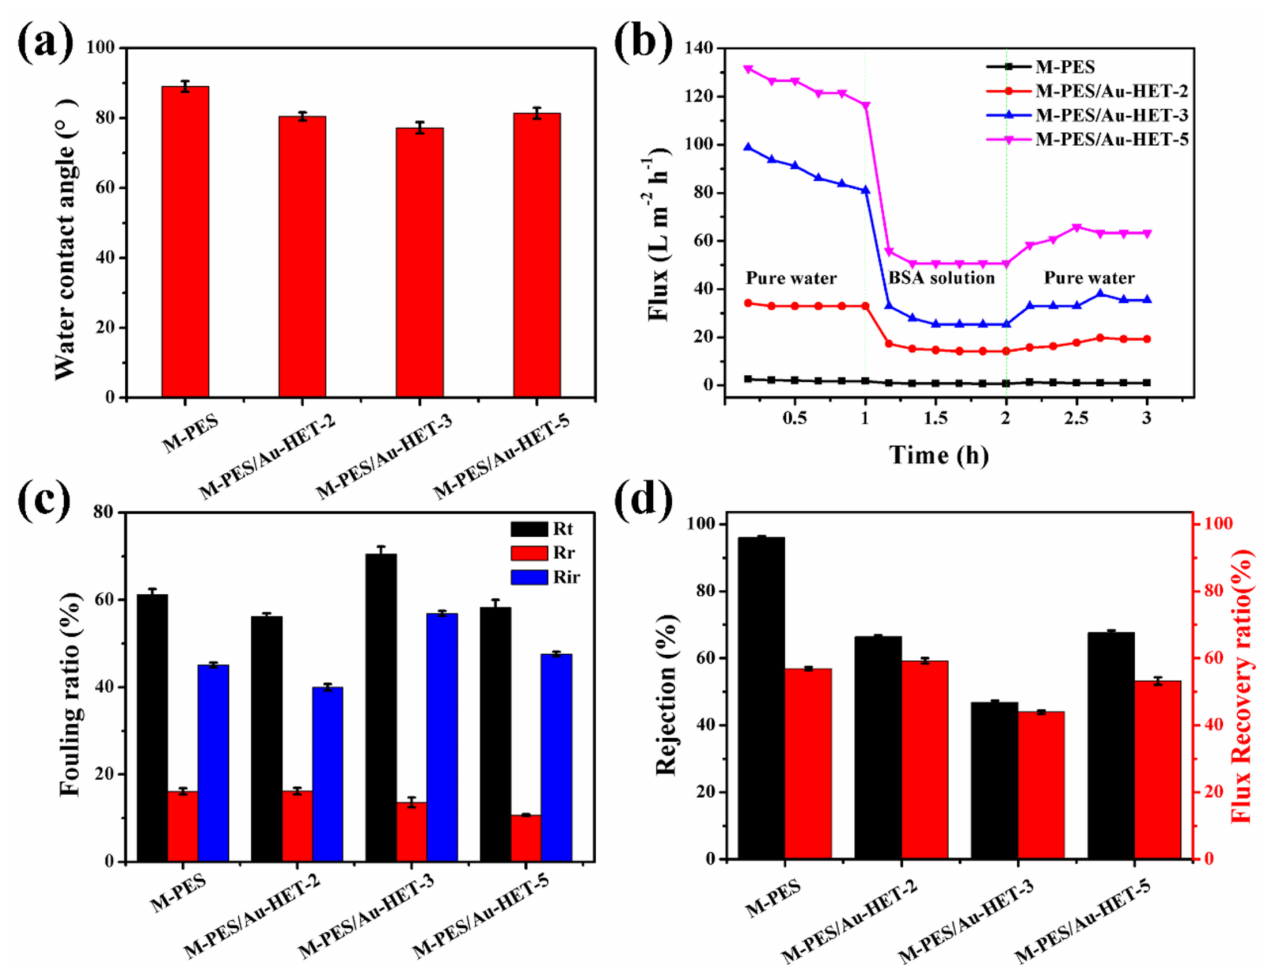
Figure 6. Properties of the pristine and modified membranes of Au-HET with contents of 0, 2, 3, and 5 wt%: ( a ) water contact angle, ( b ) time–dependent fluxes, ( c ) fouling ratios, and ( d ) water flux recovery ratios (FRR) and BSA rejection